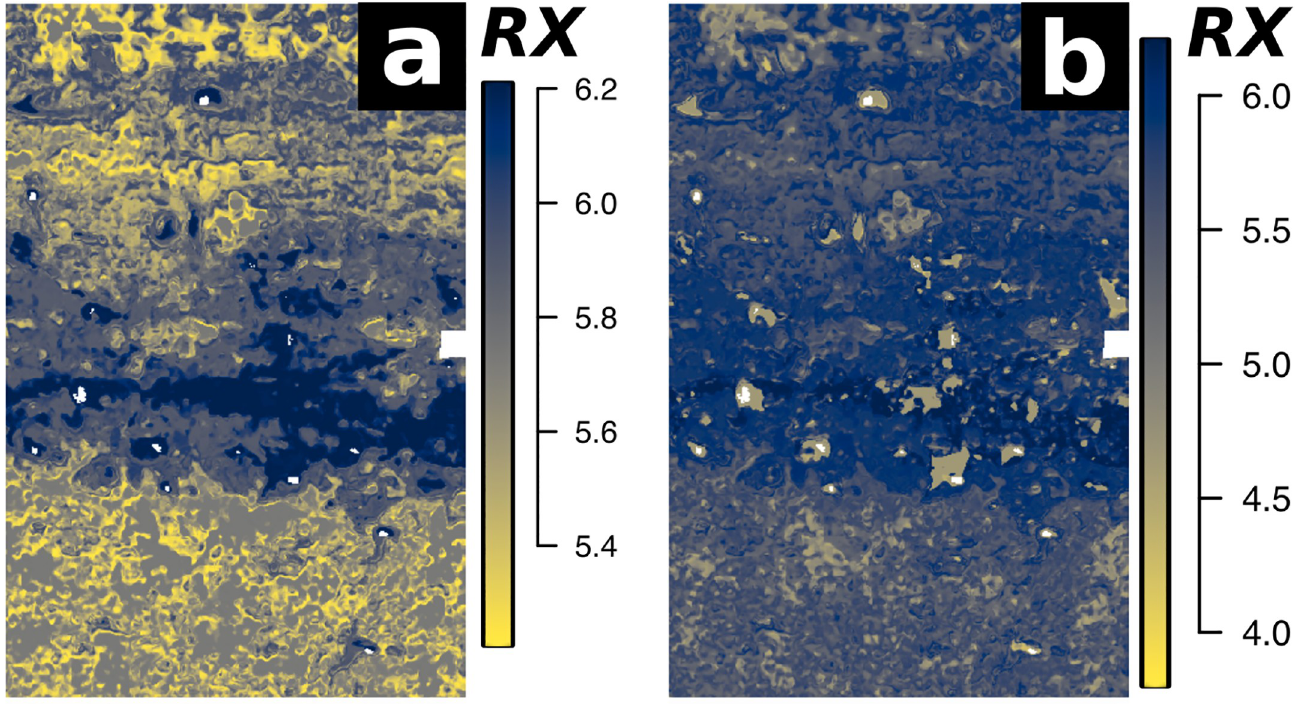
Fig 8. Predicted weathering index values (RX = Ruxton Ratio) of Profile EI. Prediction results from the regression models trained with (a) the hyperspectral image data of profile EI and (b) the combined hyperspectral image data of profiles EI and EVI. When analysing the profiles individually, significantly more detail is preserved